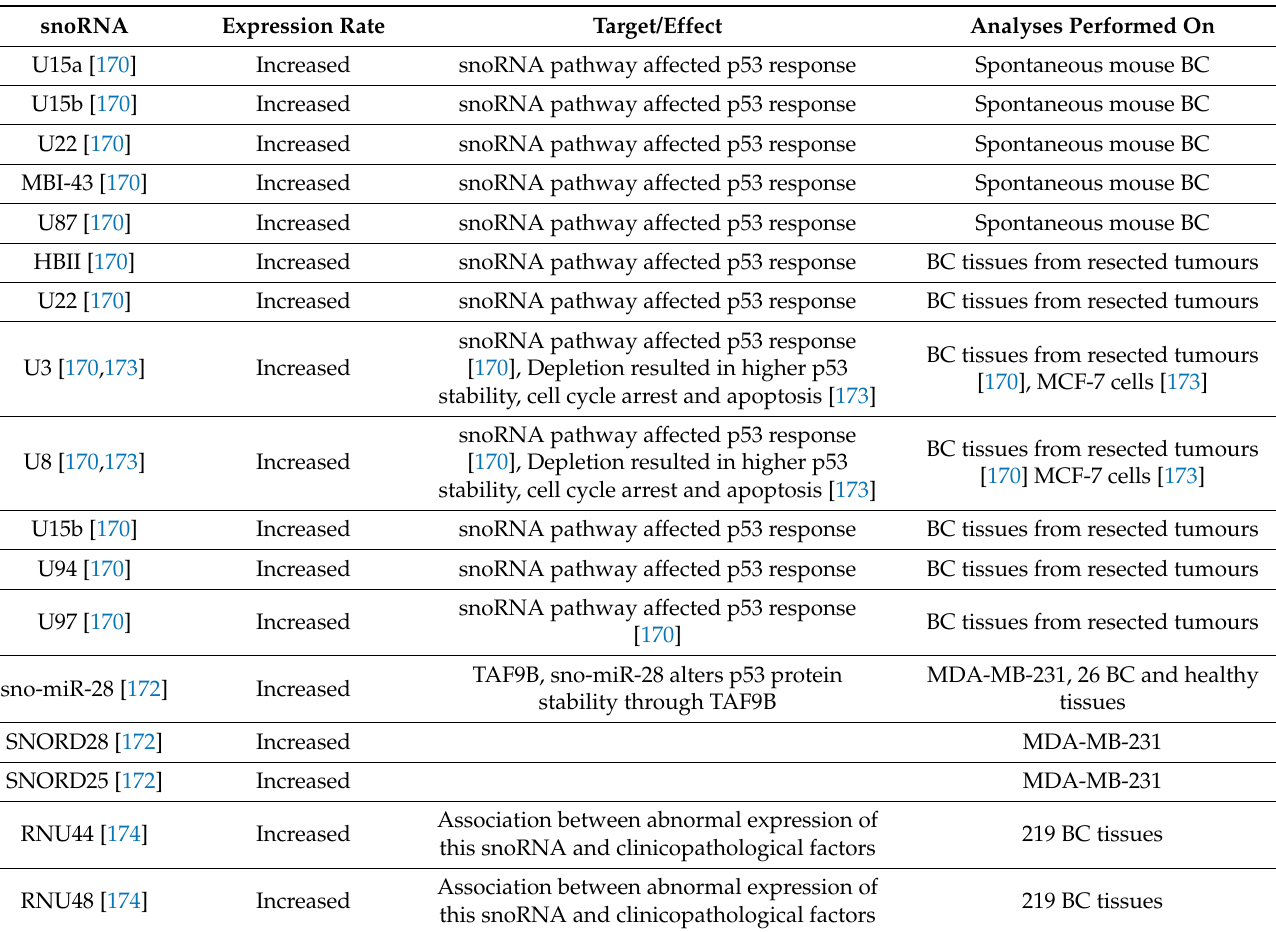
Table 3. List of snoRNA actions in BC cell lines, animal models and BC